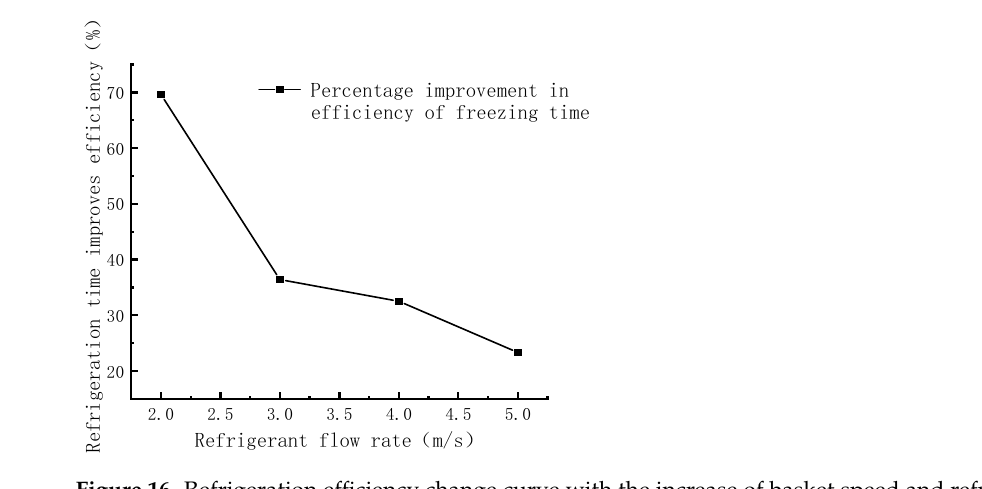
Figure 16. Refrigeration efficiency change curve with the increase of basket speed and refrigerant flow rate.